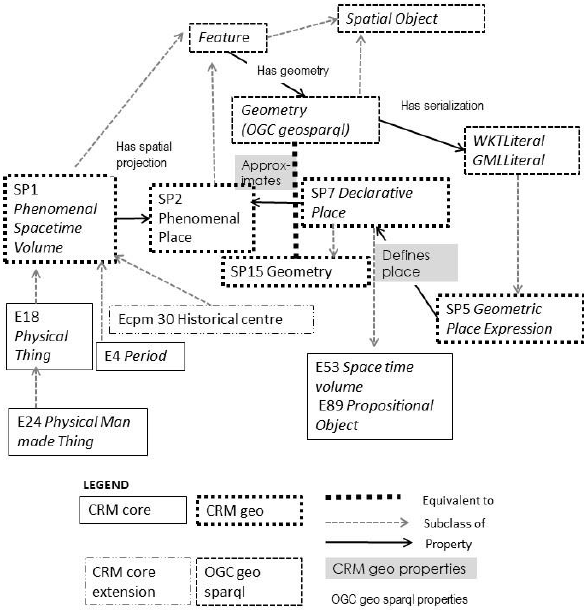
Figure 3. General schema of the relations between CIDOC and OGC models considered to develop CPM